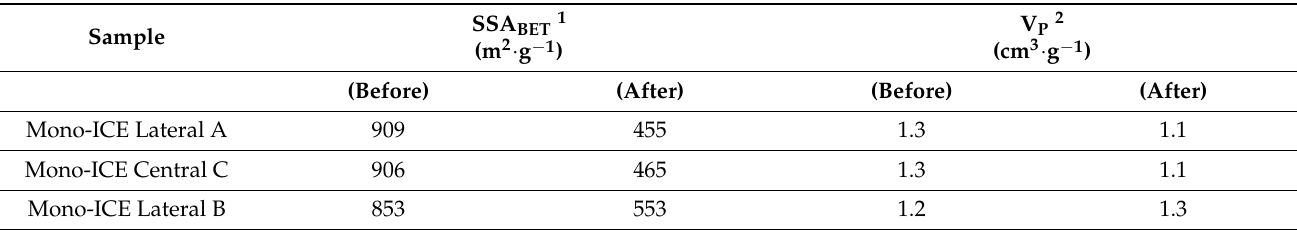
Table 1. Specific Surface Area and Total Pore Volume of Calcined Mono-ICE-Lateral A, Mono-ICE-Lateral B and Mono-ICE-Central C Samples, Before and After 36 h of Water Treatment.